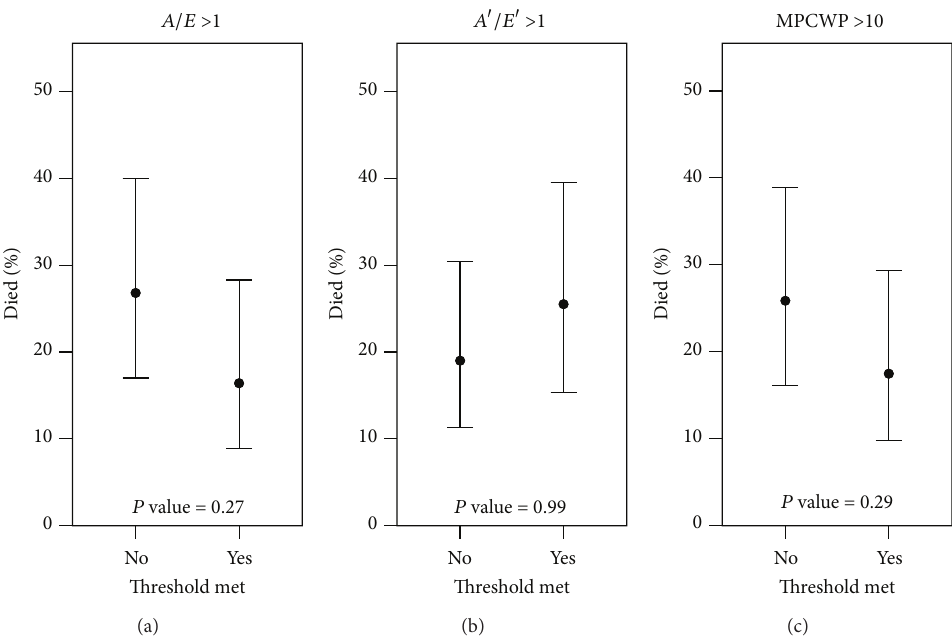
Figure 4: Echocardiographic illustration of abnormal diastolic dysfunction based upon mitral flow and mitral annulus velocity.